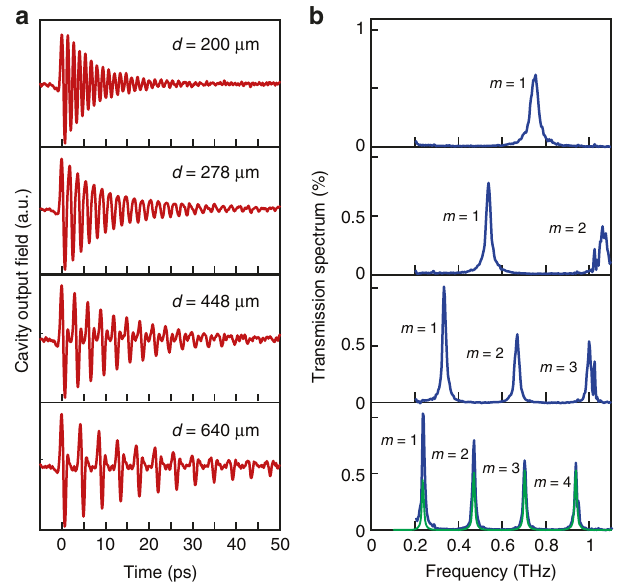
Fig. 3 Time-domain THz spectroscopy of an empty cavity. a Time-resolved THz signal measured at the output of the empty cavity with different distances, d , between the mirrors, showing the exponentially decaying oscillations of the fi eld exiting the cavity. b Transmission power spectra of the cavity with increasing cavity lengths, showing the gradual progression of the empty-cavity resonant modes. The green line shows the transmission spectrum obtained by T -matrix measured refractive index of α -lactose 52 ), shown by the green solid line, we obtain a thickness of d α L = 250 μ m for the α -lactose pellet and d air = 97 μ m for the air gap thickness. As can be seen in